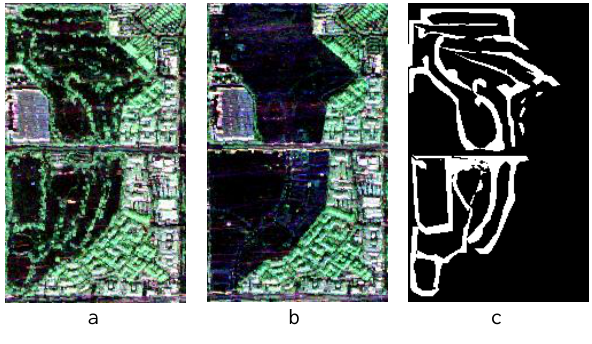
Fig. 2. Pauli images of dataset, (a) Region 1 in 2014, (b) Region 1 in 2019, (c) ground truth Region 1.